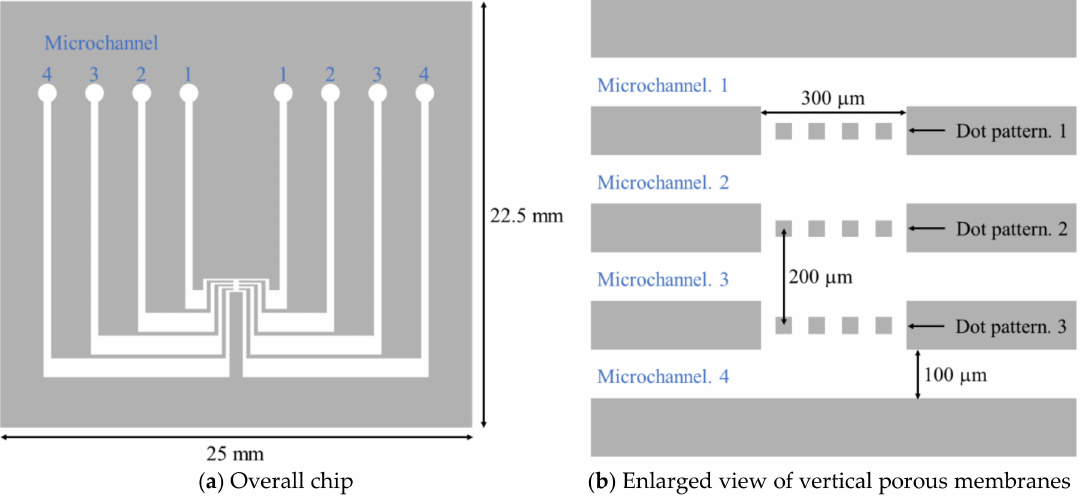
Figure 8. Schematics of microchannel integrated with vertical porous membranes. In the design, there are four individual microchannels. Each microchannel is connected by only the pores on the vertical porous membranes. In the vertical porous membrane, the width is 300 µ m, and the interval of each vertical porous membrane is 200 µ m. The dot size is 4 µ m, and the interval is 10 µ m for fabricating the micropores of the vertical porous membrane.